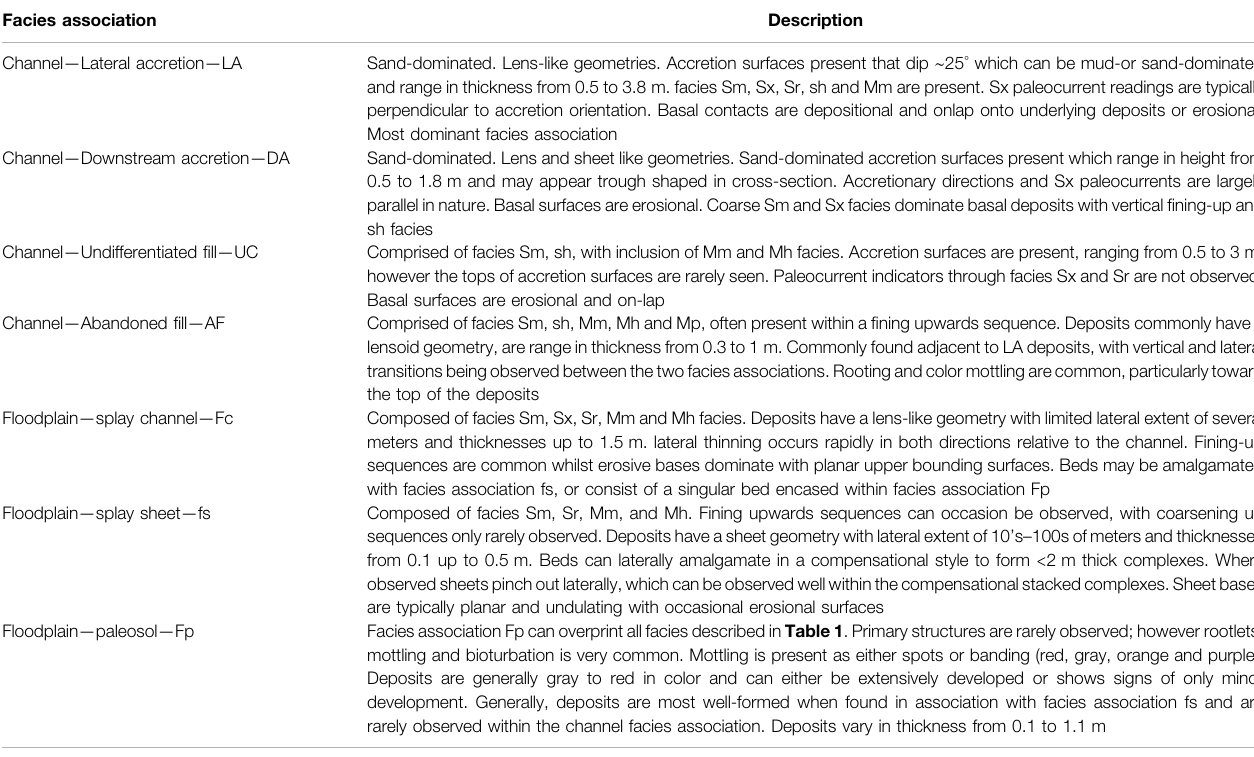
TABLE 2 | Summary descriptions of facies and sub facies associations on the Huesca